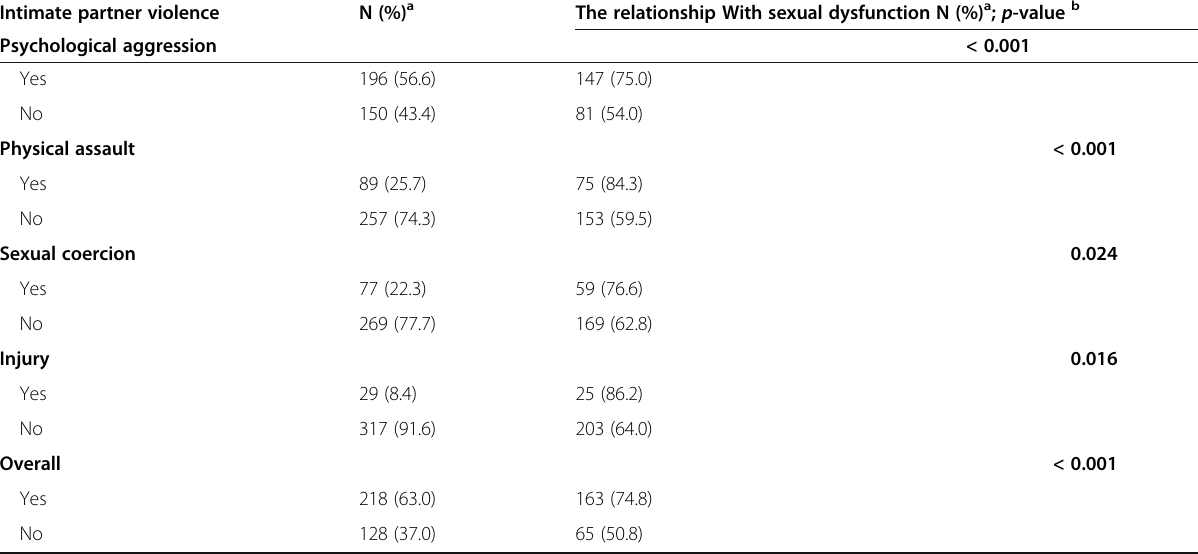
Table 3 Prevalence of intimate partner violence in young pregnant women and its correlation with sexual dysfunction ( n = 346) Intimate partner violence N (%) a The relationship With sexual dysfunction N (%) a ; p -value b Psychological aggression <